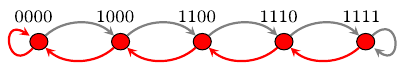
FIG. 4. TIL transition graph with L ¼ 4 and no secondary mutations. The ordering sequence is of the form given in Eq. (6). The transition graph is unique for this ordering sequence, and it is identical to the graph for the Preisach